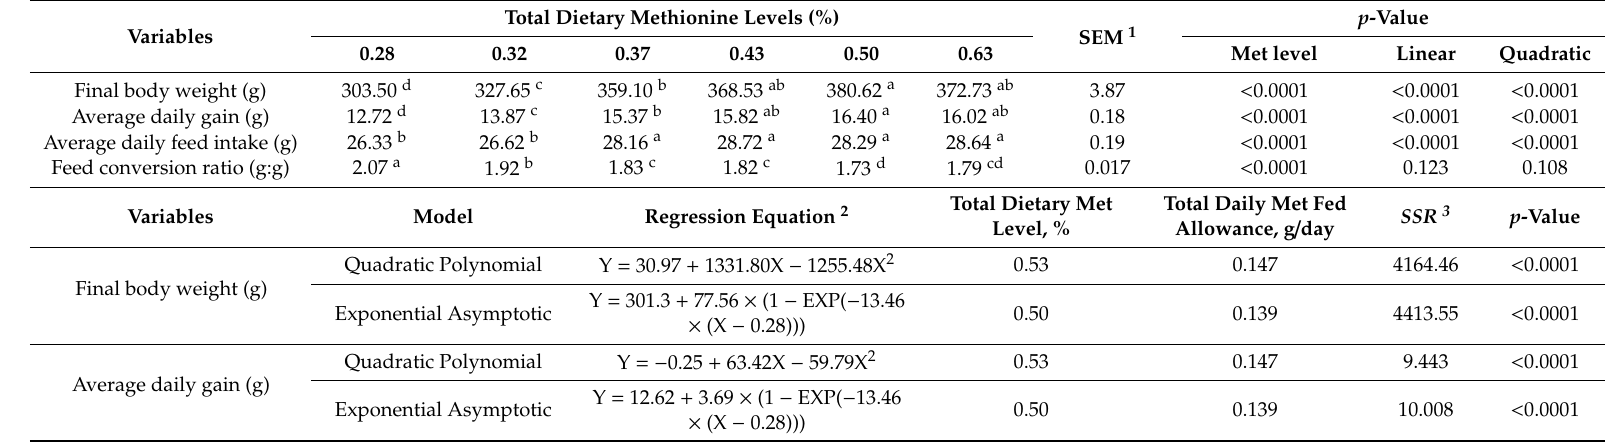
Table 4. E ff ects of total dietary methionine level on growth performance of mixed male and female Lingnan yellow-feathered chickens aged 1–21